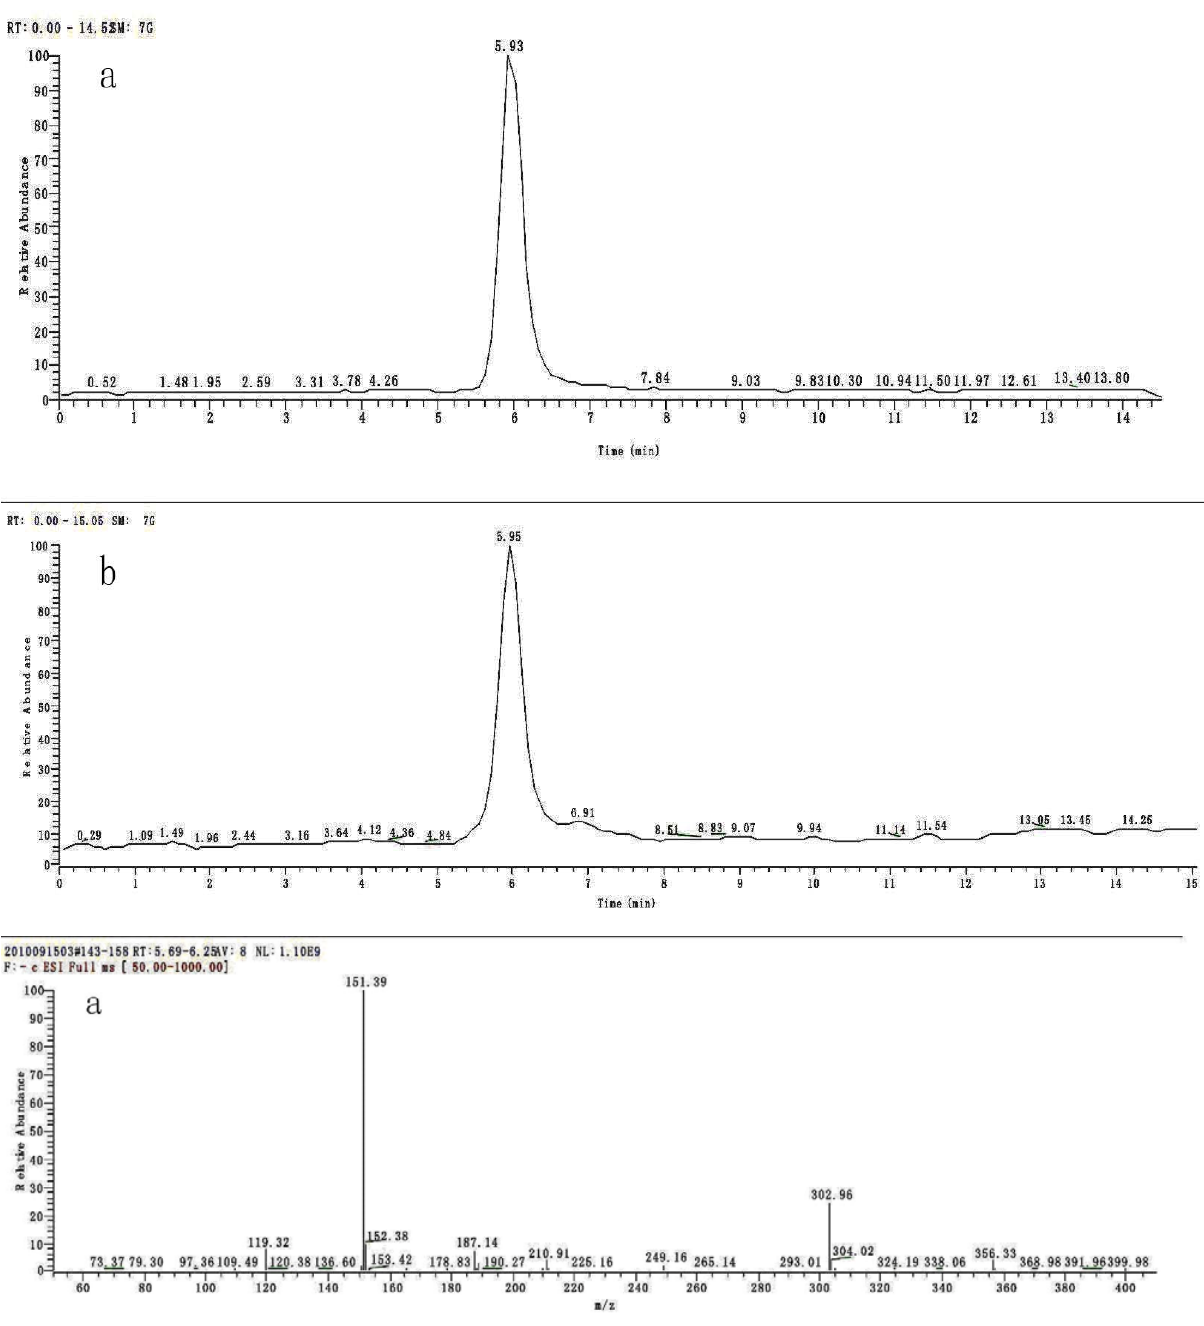
Figure 1. The result of LC-MSD analysis (a: crystal sample; b: DHAP authentic